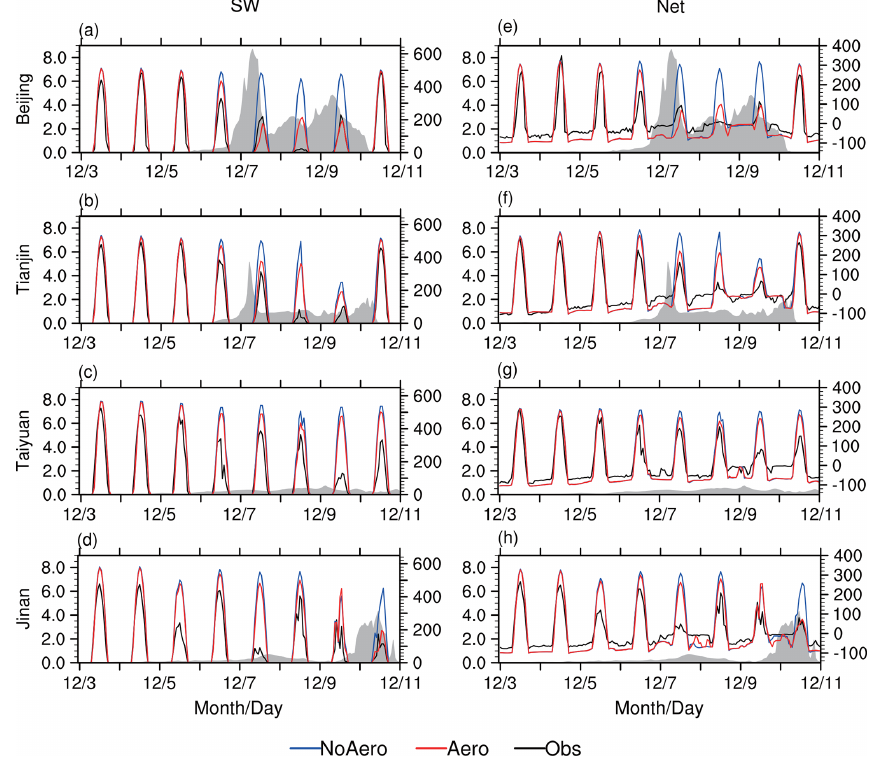
Figure 8. (a–d) Observed (black) and WRF-simulated (NoAero: blue, Aero: red) temporal variation of downward shortwave radiation at the surface (Wm − 2 , right axis) in (a) Beijing, (b) Tianjin, (c) Taiyuan and (d) Jinan. The gray areas indicate the simulated AOD (left axis) by WRF-Chem. Panels (e–h) are the same as (a–d) , but for net radiation at the surface (Wm − 2